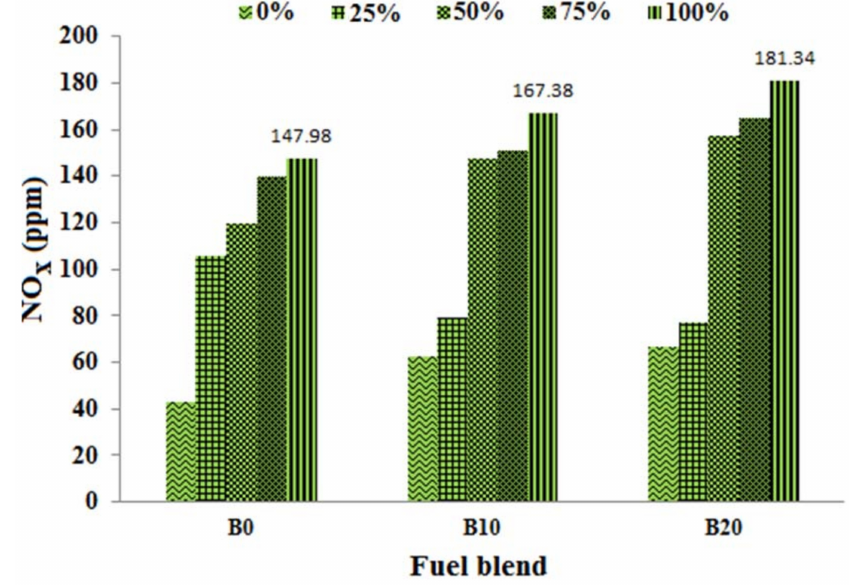
Figure 10. Results of nitrogen oxides (NOx) for different fuel blends at the constant speed of 2100